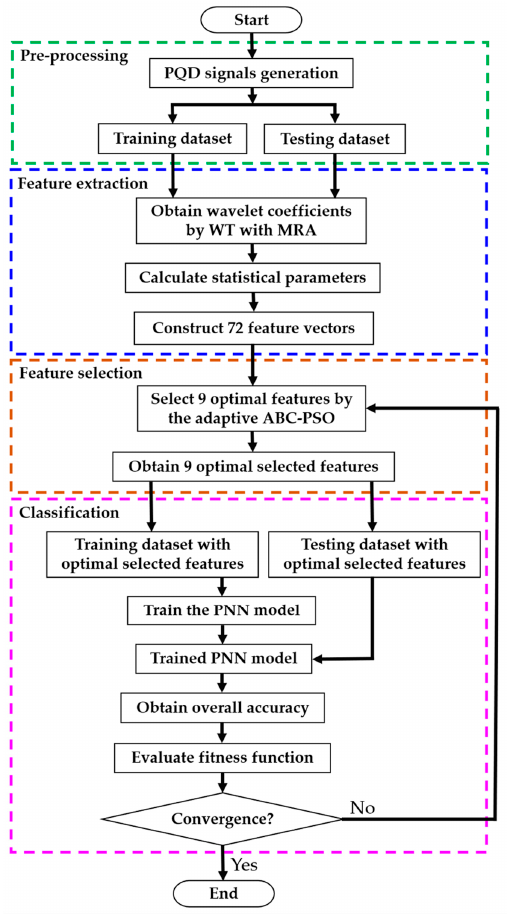
Figure 1. The flowchart of PQD classification. PNN, probabilistic neural network; ABC, artificial bee colony; PSO, particle swarm optimization; WT, wavelet transform; MRA, multi-resolution analysis.